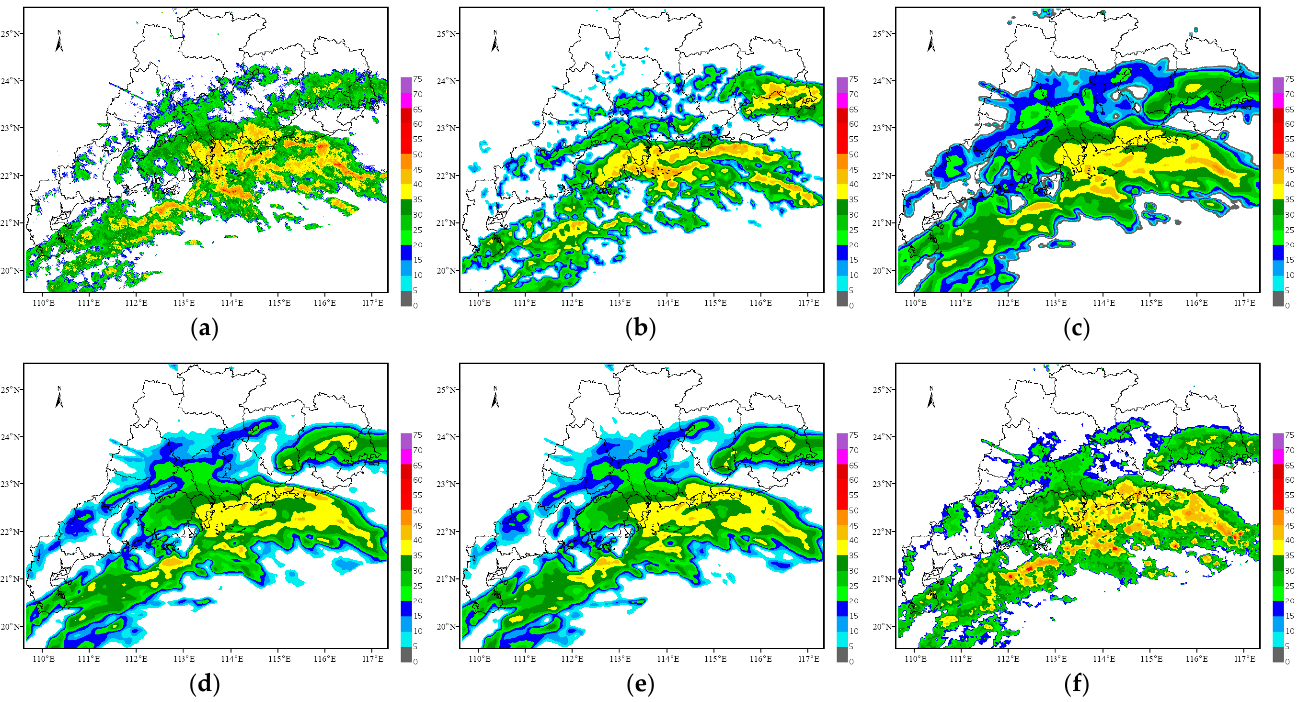
Figure 10. Nowcasting results of the typhoon process for the next 0.5 h. ( a ) Observation; ( b ) Opti- calflow; ( c ) ConvGRU; ( d ) PredRNN; ( e ) PredRNN V2; ( f ) TSGAN.